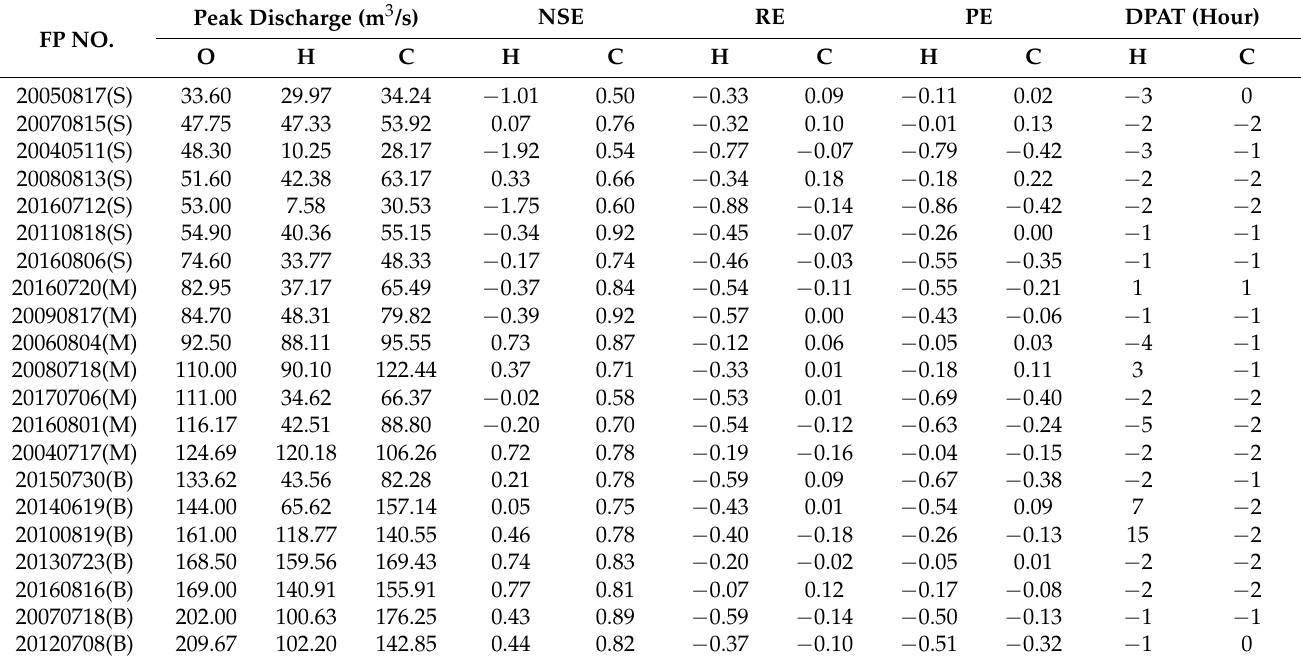
Table 5. The statistical analysis of the measured and simulated discharge in flood processes.